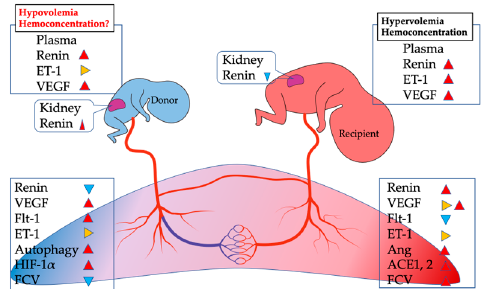
Figure 4. A schematic depicting the expression profile of TTTS-related factors in donor and recipient. Red, blue, and yellow triangles indicate high, low, and equal expression or concentration, respectively. Abbreviations: ACE, angiotensin-converting enzyme; Ang, angiotensin; ET-1, endo-